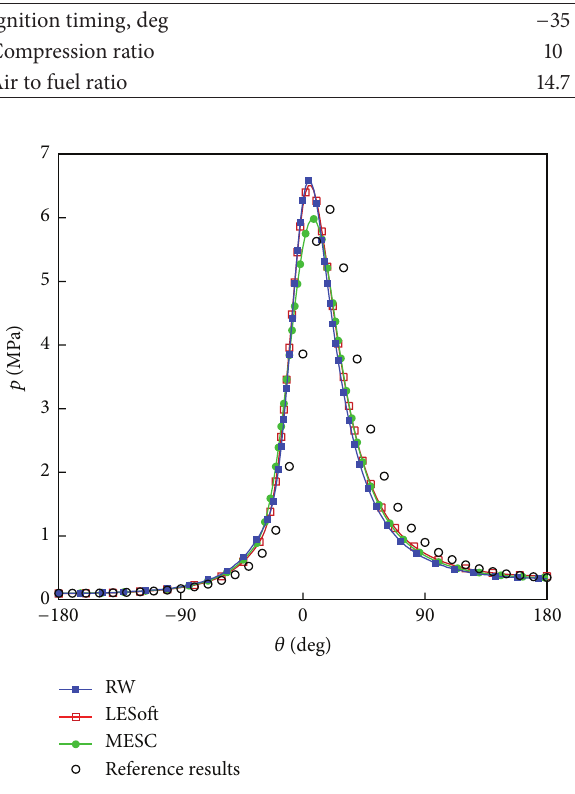
Figure 8: Comparison of pressure profiles with reference data of